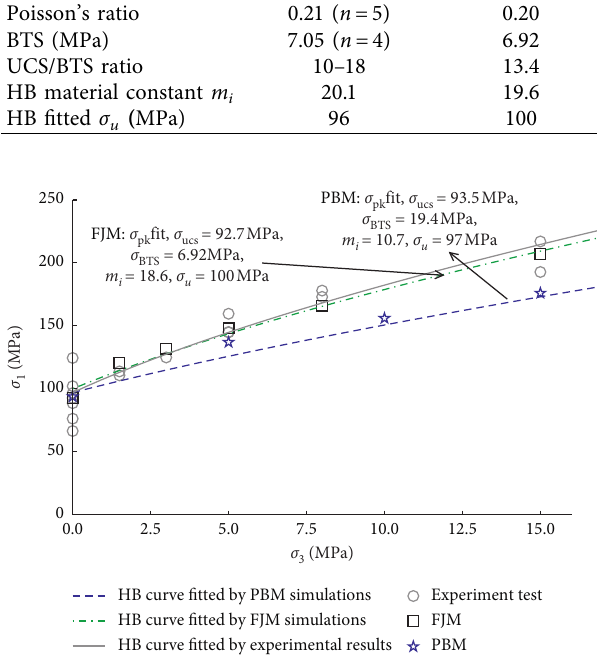
Figure 9: Peak strength of the intact tuff from laboratory and numerical tests.